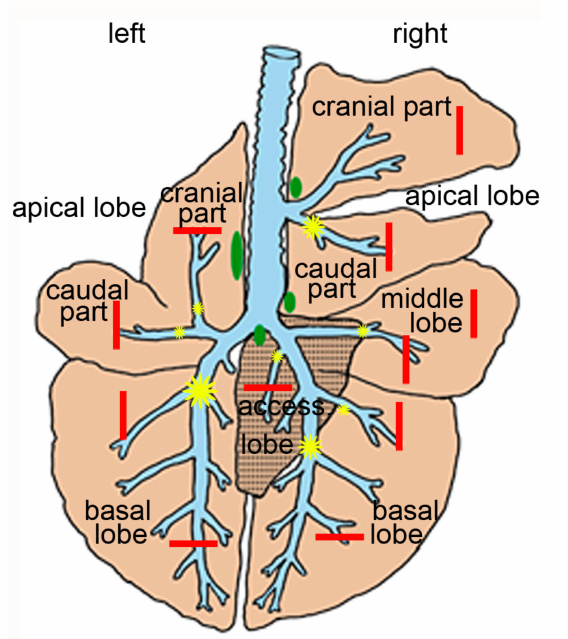
Figure9. Schematicdrawingofbovinelung. Inoculationsitesareindicatedasyellowstars(small—0.5mL, middle-sized—1.0 mL and large—1.5 mL), sampling sites as red bars and and regional lymph nodes in